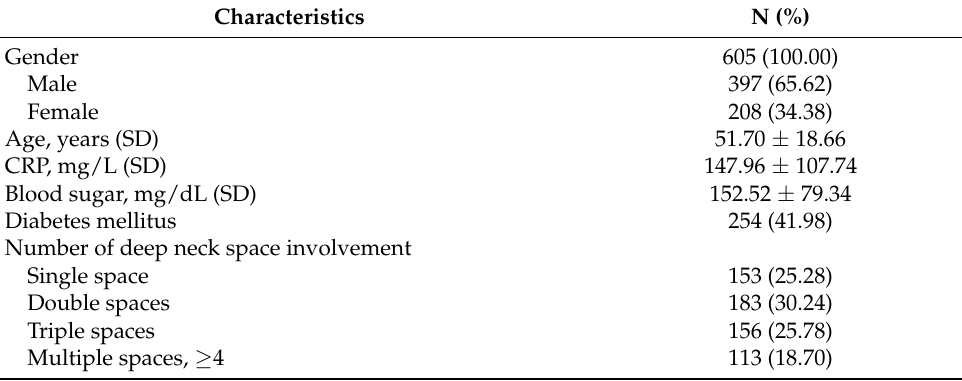
Table 1. Clinical characteristics of the 605 DNI patients undergoing surgical